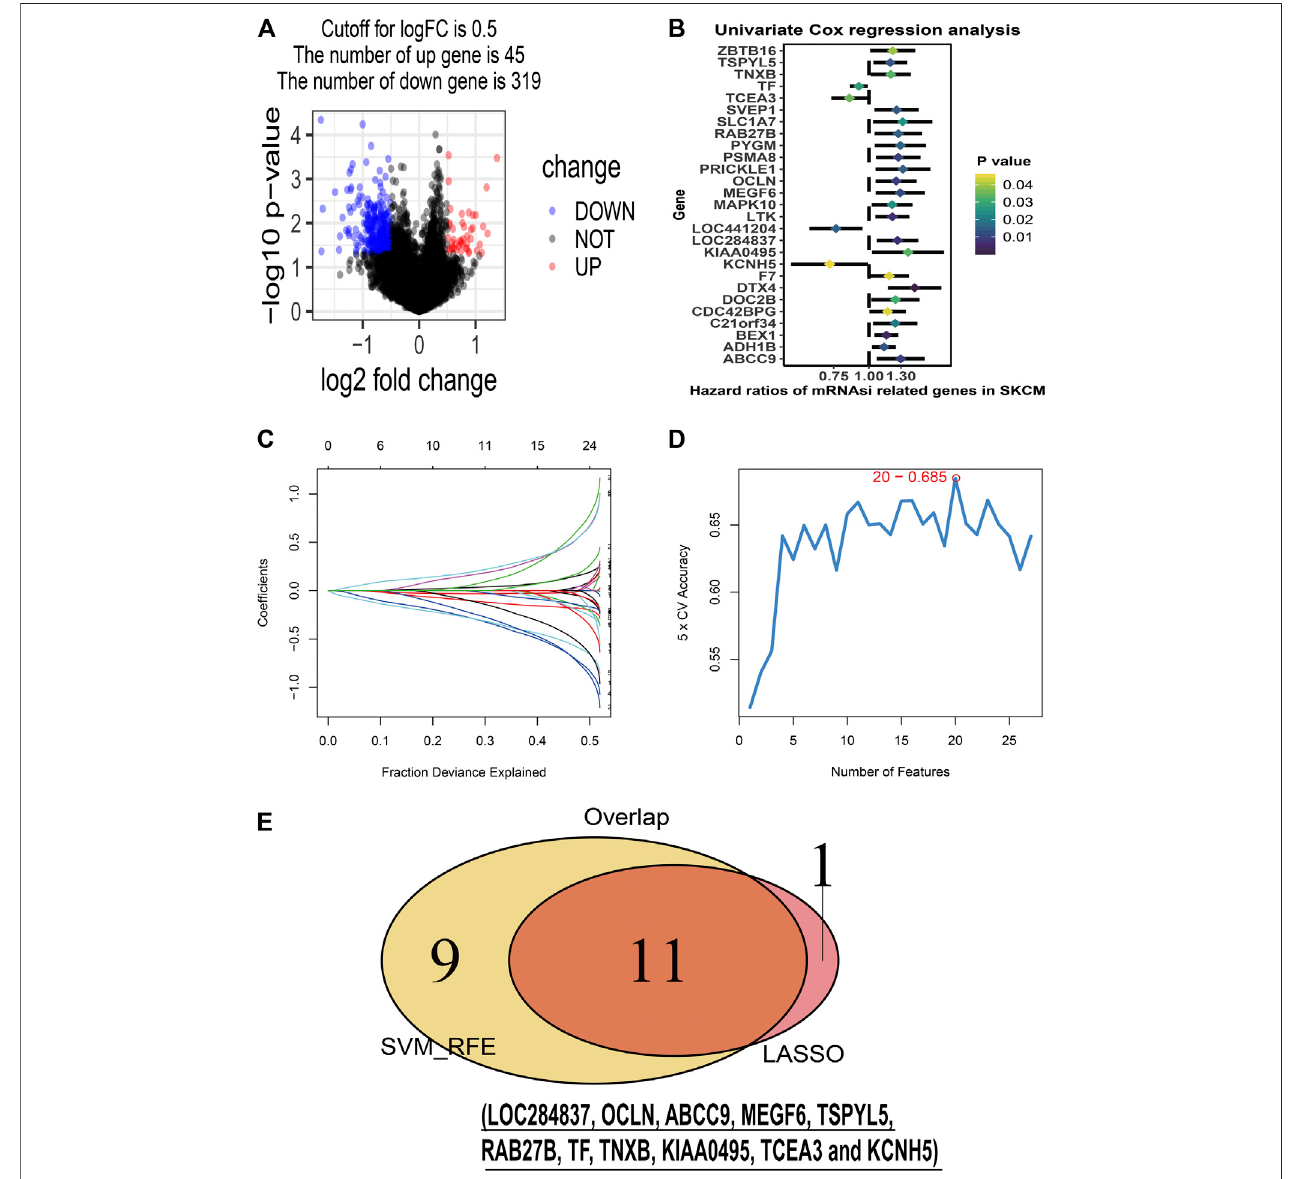
FIGURE 4 | Stemness-related genes feature selection. (A) : volcano plot of the differentially expressed stemness-related genes in training dataset; (B) : forest plots of the prognostic differentially expressed stemness-related genes; (C) : the Least Absolute Shrinkage and Selection Operator (LASSO) algorithm coef fi cient pro fi les of the 12 genes that met the prognostic criteria initially; (D) : Support Vector Machine-Recursive Feature Elimination (SVM-RFE) algorithms. The point highlighted indicates thelowesterrorrate,andthecorrespondinggenesatthispointarethebestsignatureselectedbySVM-RFE. (E) :theVennplotofoverlapgenesselectedbyLASSO and SVM-RFE